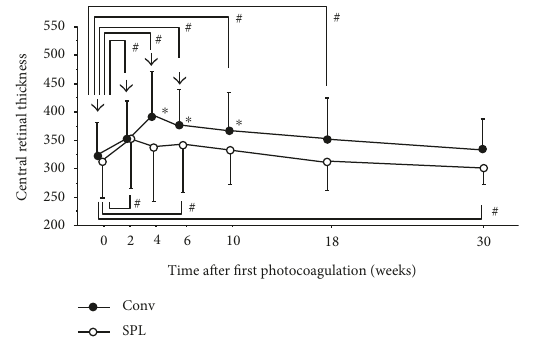
Figure 1: Changes in central retinal thickness (CRT) after four sessions of panretinal photocoagulation (PRP). Data represent mean ± standard deviation (SD). Arrow indicates the timing of PRP. # p < 0 05 (compared with CRT at PRP initiation), ∗ p < 0 05 (Conv group versus SPL